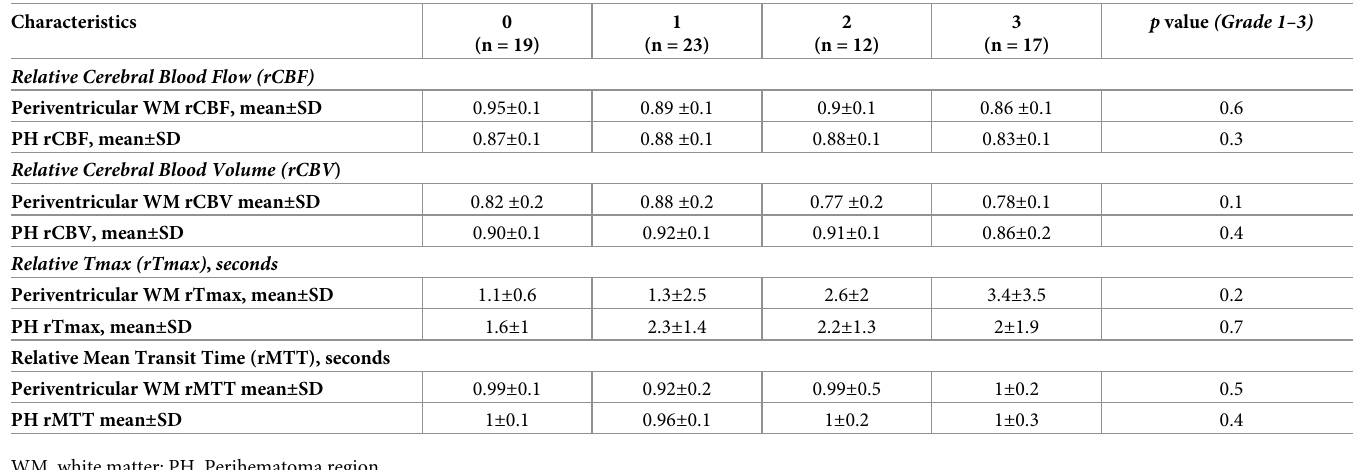
Table 3. Cerebral perfusion parameters in white matter regions according to leukoariaosis severity (Fazekas grade).